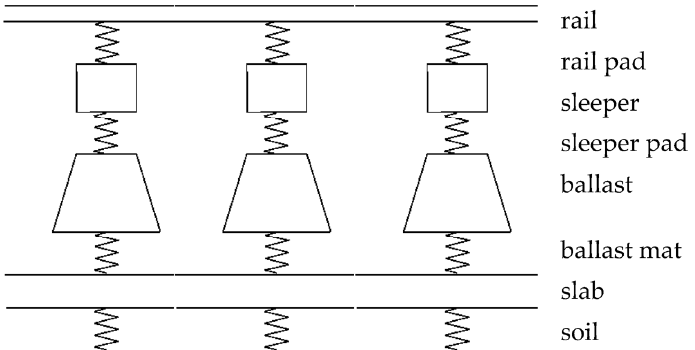
Figure 2. Track model consisting of rail, rail pad, sleeper, sleeper pad, ballast, ballast mat, ballast plate and continuous soil.